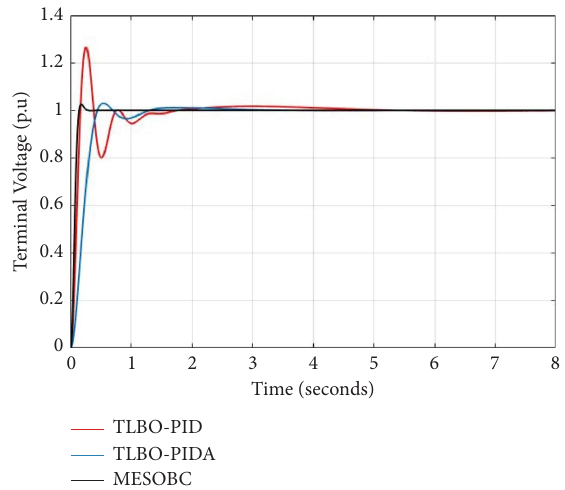
Figure 10: Response of terminal voltage with +50% uncertainties in T